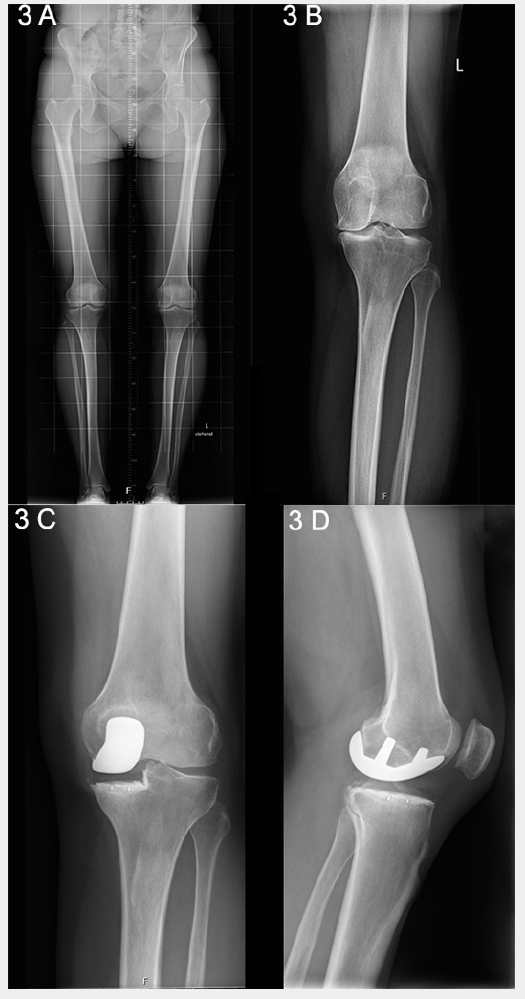
Patellofemoral joint (PFJ) arthritis. A. Skyline X-Ray showing PFJ osteoarthritis. B. Skyline X-ray after PFJ replacement. C. Lateral X-ray showing PFJ osteoarthritis. D. Postoperative lateral X-ray after PFJ arthroplasty. E. Anteroposterior X-ray after PFJ arthroplasty.